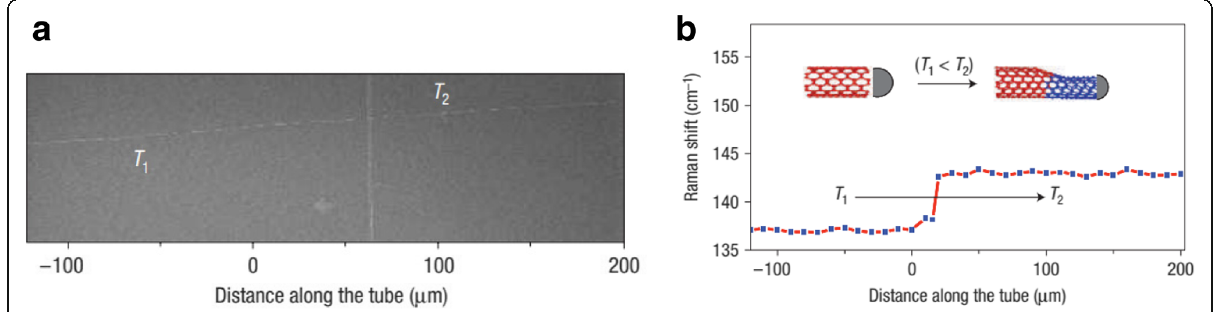
Fig. 20 a SEM image of a two-terminal SWCNT intramolecular junction formed by varying the temperature during CVD growth from 950 to 900 °C (temperatures are indicated by T 1 and T 2 ). Adapted from [141]. b The corresponding shift in the Raman spectra with variations in the temperature. Inset shows the schematic illustrations of SWNT diameter variations with temperature. Adapted from [141]